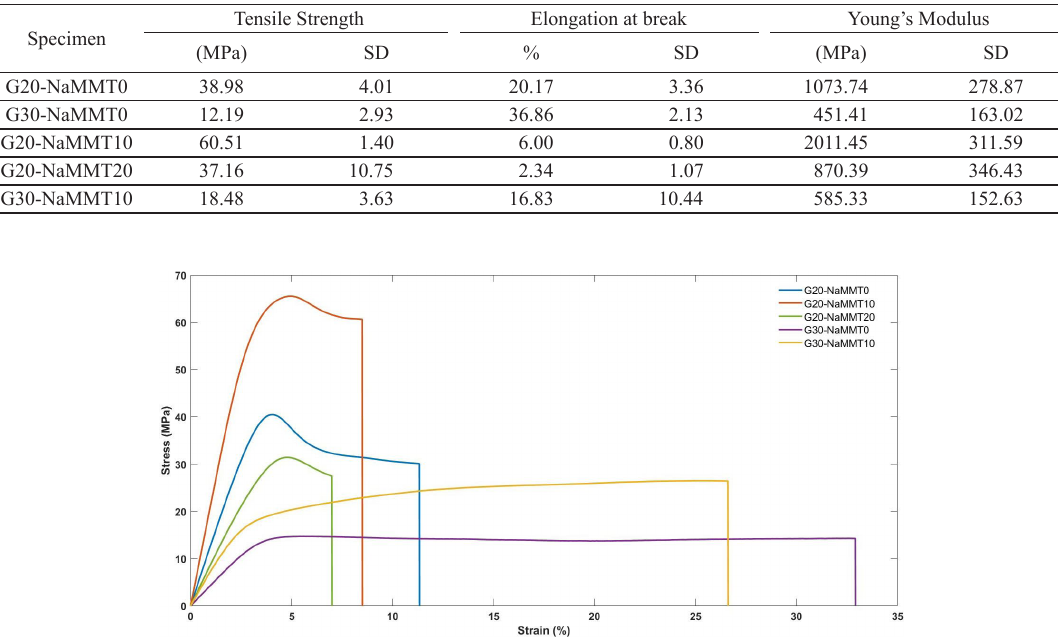
Figure 3. The regression stress-strain curves for the conventional and nanocomposite films G20-NaMMT0, G20-NaMMT10, G20-NaMMT20, G30-NaMMT0 and G30-NaMMT10 with 20 and 30 wt% glycerol concentrations, with different contents of nanoclay 10 and 20 wt%